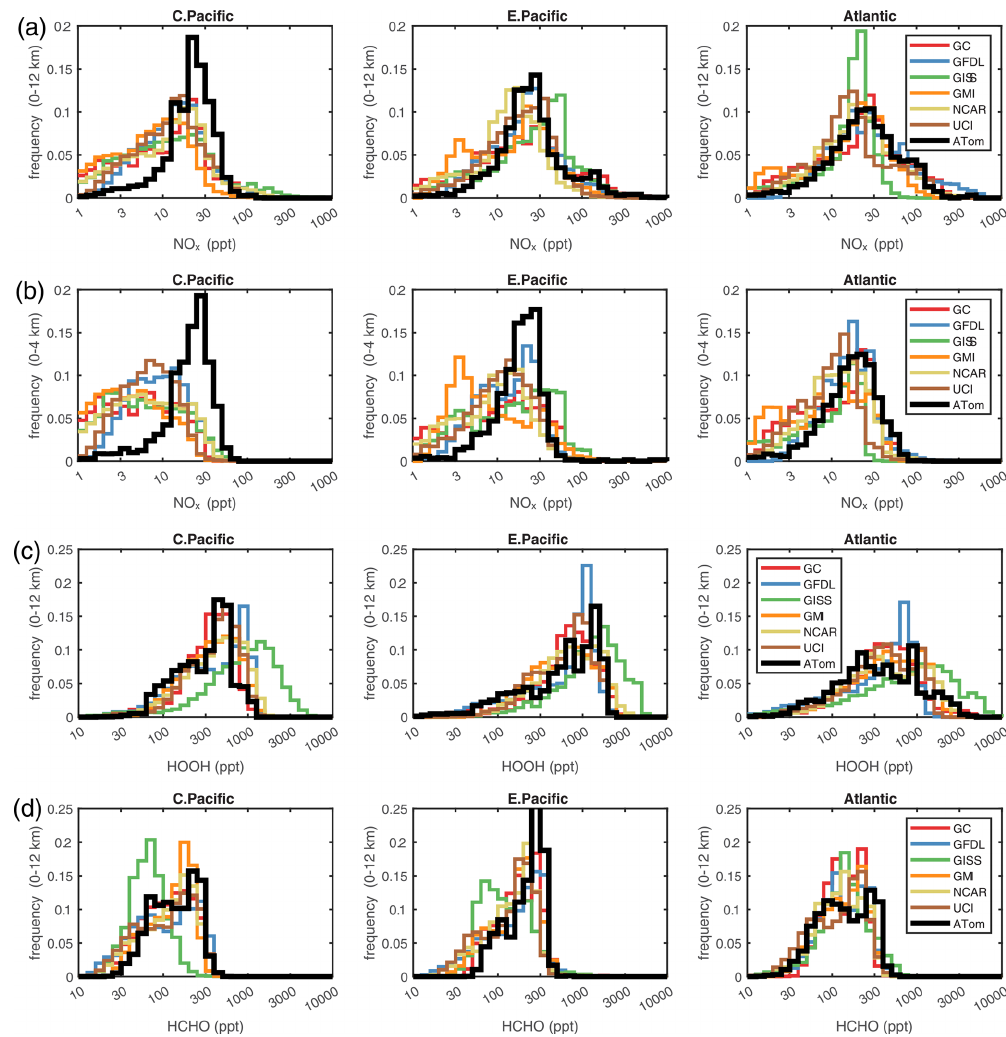
Figure 4. Histograms of probability densities (PDs) of NO x (0–12km, a ), NO x (0–4km, b ), HOOH (0–12km, c ), and HCHO (0–12km, d ) for the three tropical regions (central Pacific, eastern Pacific, and Atlantic). The ATom-1 data are plotted on top of the six global chemistry models’ results for a day in mid-August and sampled as described in Fig.